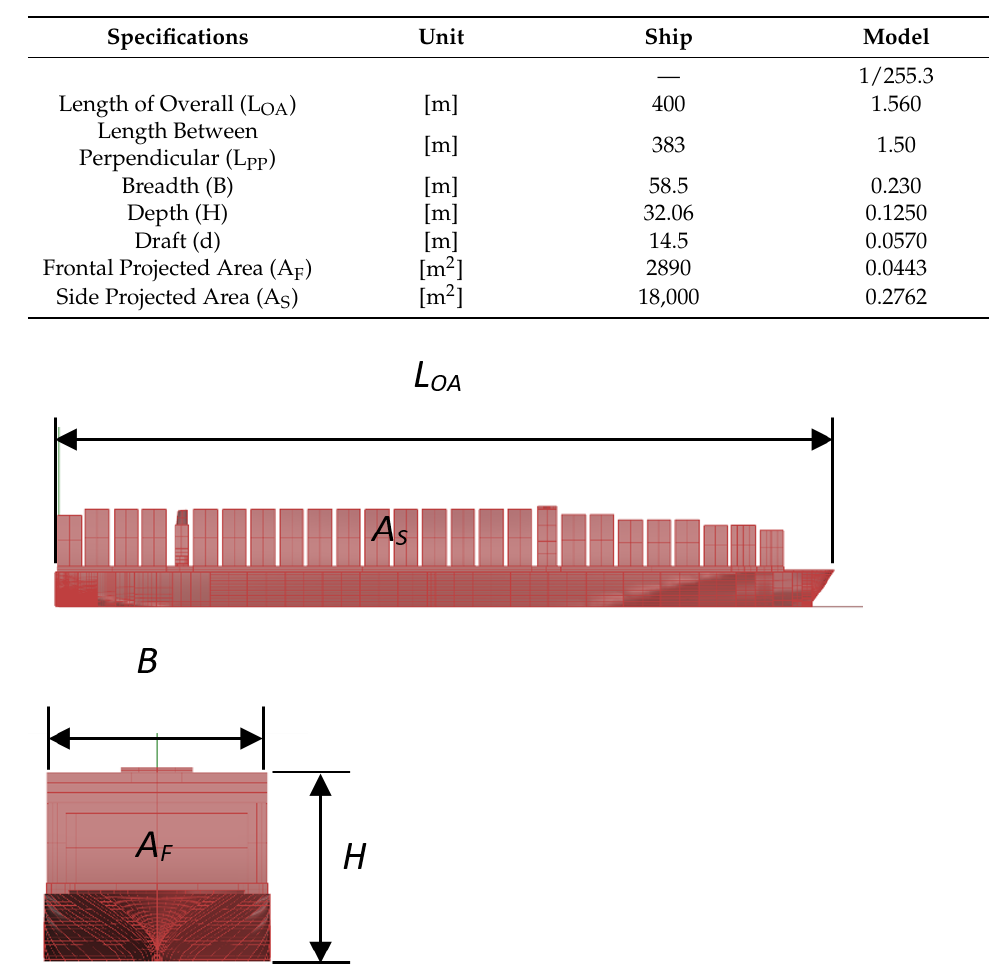
Figure 1. Side and frontal profiles of the modeled container ship in a fully loaded condition. Table 1. Principal particulars of ship and model.